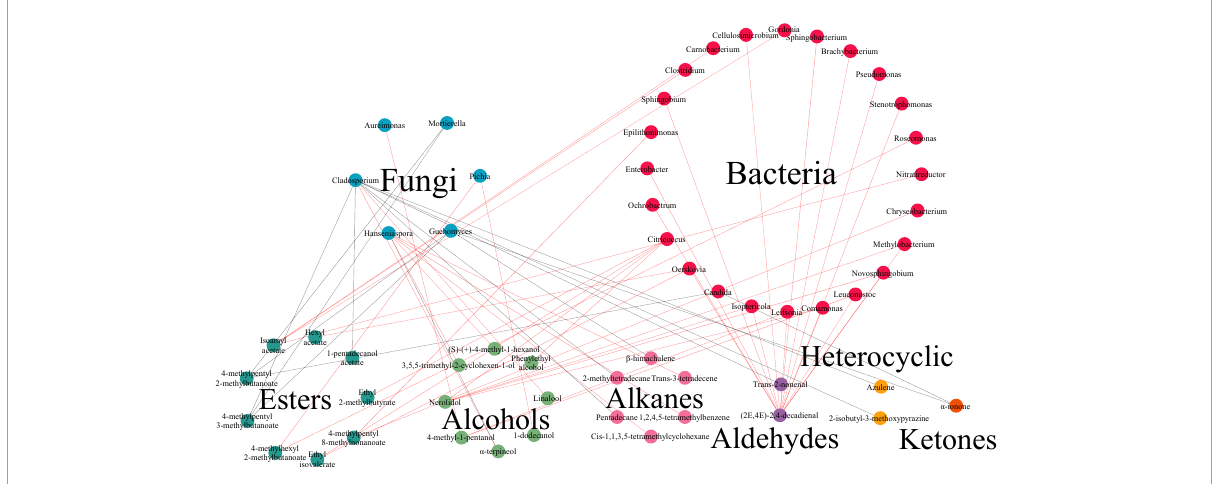
FIGURE7 Analyses of correlation between microbiota and volatile components by bidirectional orthogonal partial least squares (O2PLS) modeling during the production of fermented minced peppers. Correlation network between microorganisms and volatile components during fermentation. Red lines indicate positive correlations. Gray lines indicate negative